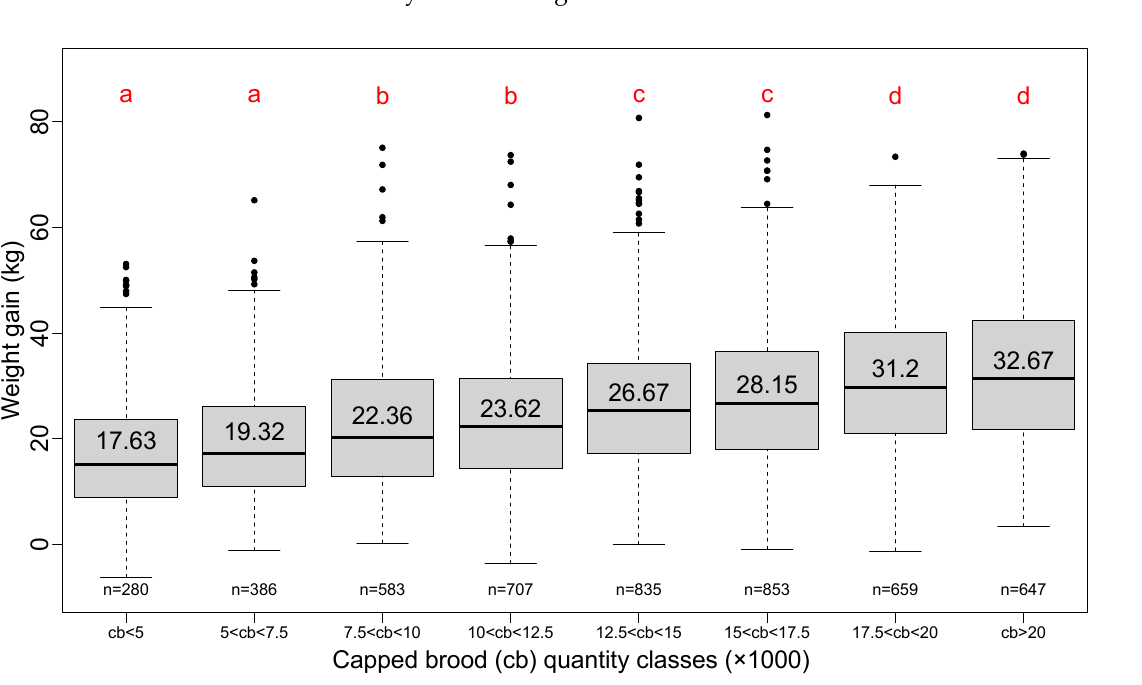
Figure 4. Boxplot series of eight classes of capped brood quantity. Step of increase: 2500 cells of capped brood. Red letters result from a pairwise Student test ( p -value < 0.05). Number in each box plot is the average total weight gain for that class. Number “n=” below each box plot is the number of hives surveyed for that class. Annual variations are shown in Appendix A: Figure A1.